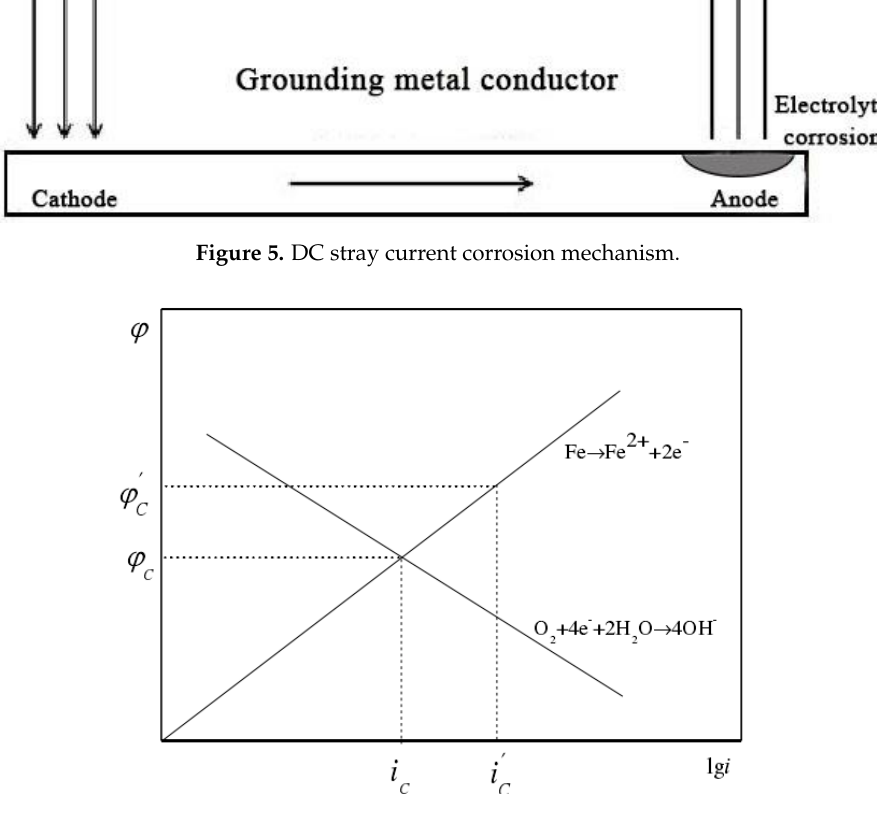
Figure 7. Sulfate reducing bacteria corrosion diagram.